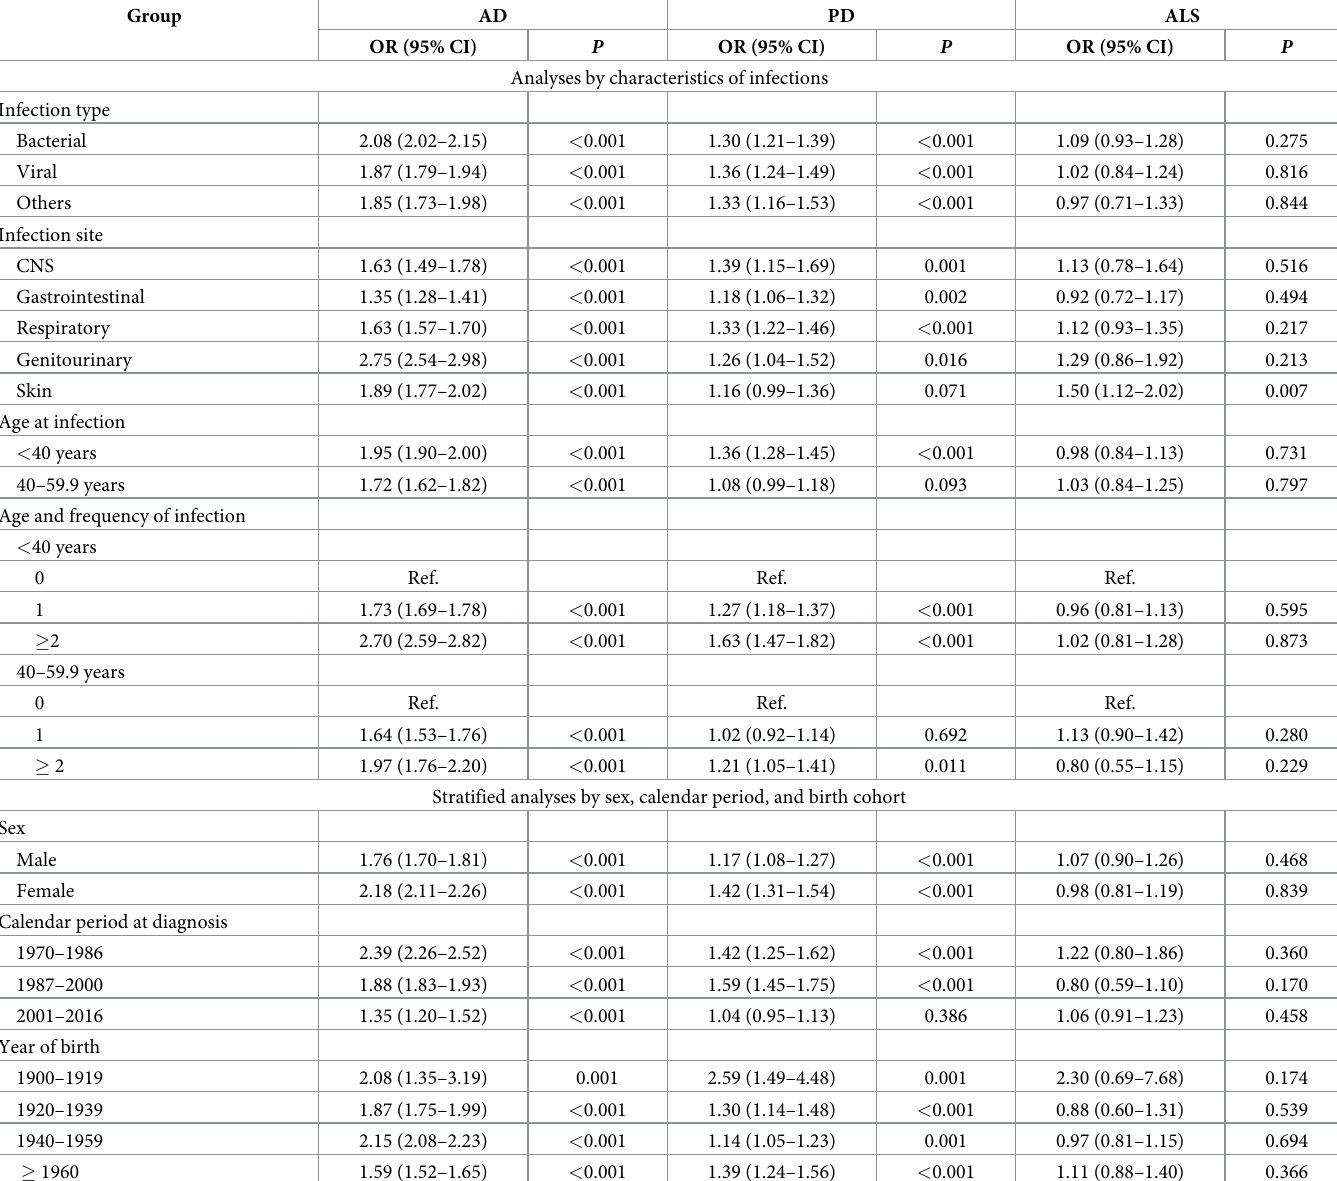
Table 3. Association between hospital-treated infection and risk of neurodegenerative disease diagnosed before 60 years.